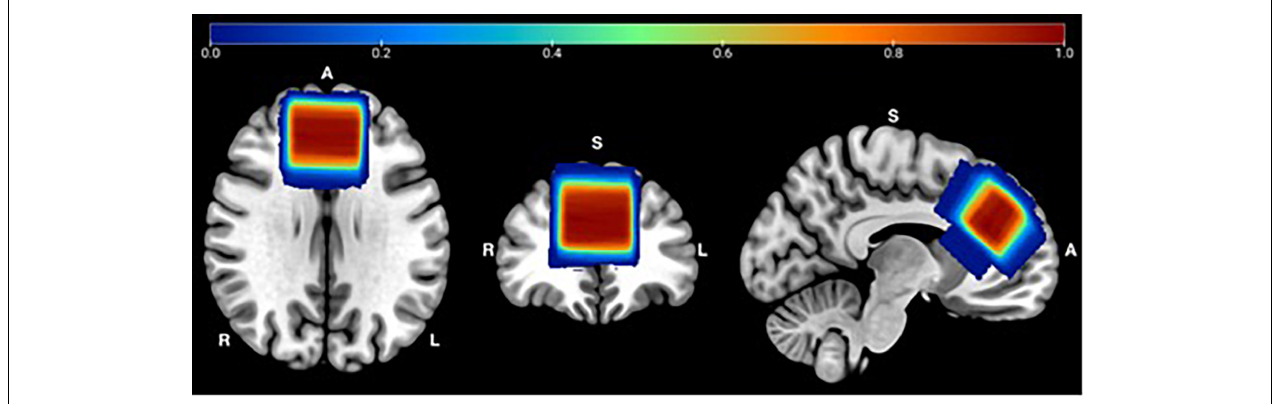
FIGURE 1 | MRS Voxel Overlap: Referencing the T1 image, a single voxel was positioned medially on the axial plane, aligned with the corpus callosum and superior to the genu of the corpus callosum. Abbreviations: R = Right; L = Left; A = Anterior; S = Superior.